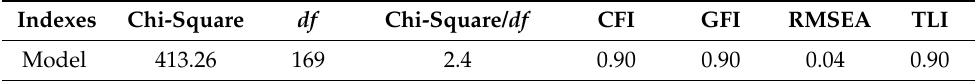
Table 3. Model fit indices of CFA for the Institutional Identity Scale for University Students ( N = 200).